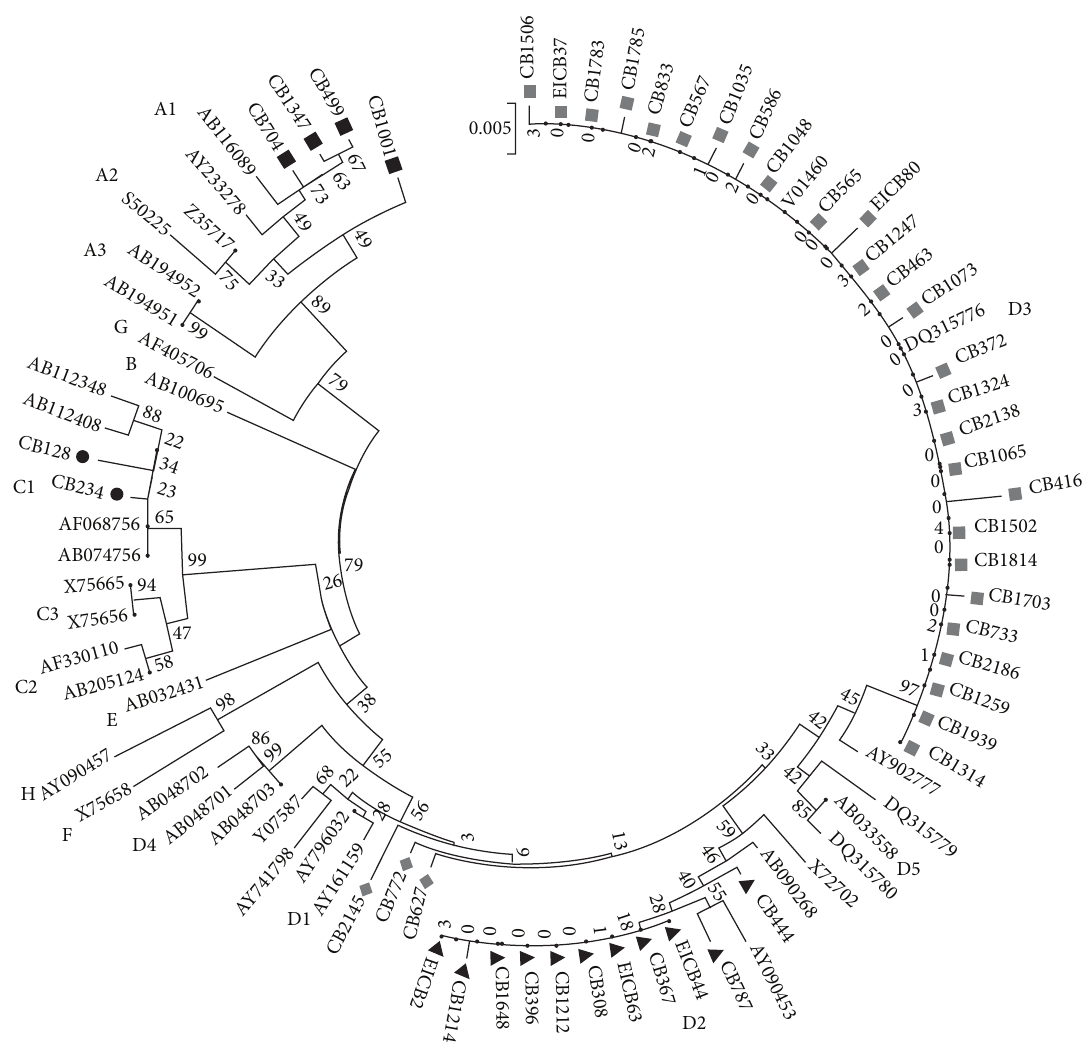
Figure 1: Phylogenetic analysis of partial S gene region sequence (300 base pairs) of HBV isolates from Eastern Indian voluntary blood donors with OBI (denoted with “CB”). Different genotypes and subgenotypes are assigned with respect to reference sequences retrieved from the GenBank. The phylogenetic tree was constructed by neighbor joining (NJ) method. The bootstrap values obtained from 1,000 replicates are given at the internal